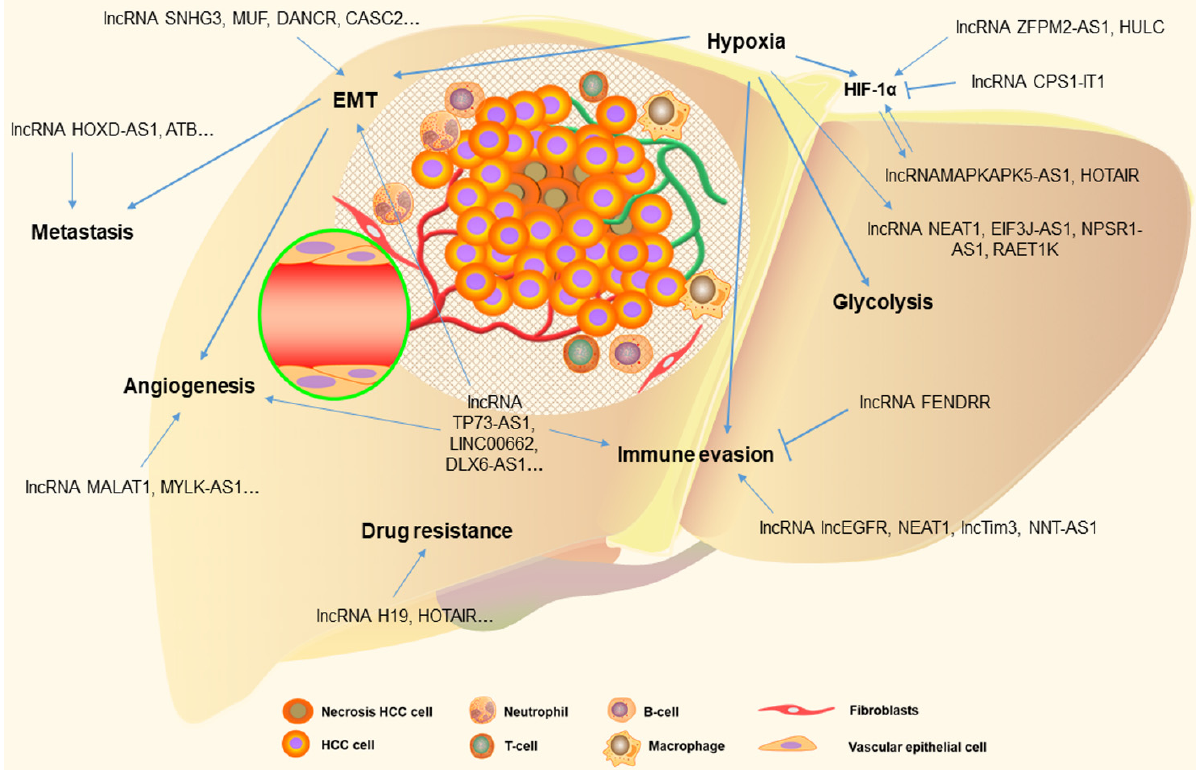
Figure 2. Long non-coding RNAs involved in the complex tumor microenvironment of HCC. LncRNA, long non-coding RNA; EMT, epithelial–mesenchymal transition; HIF-1 α , hypoxia-inducible factor 1 α .